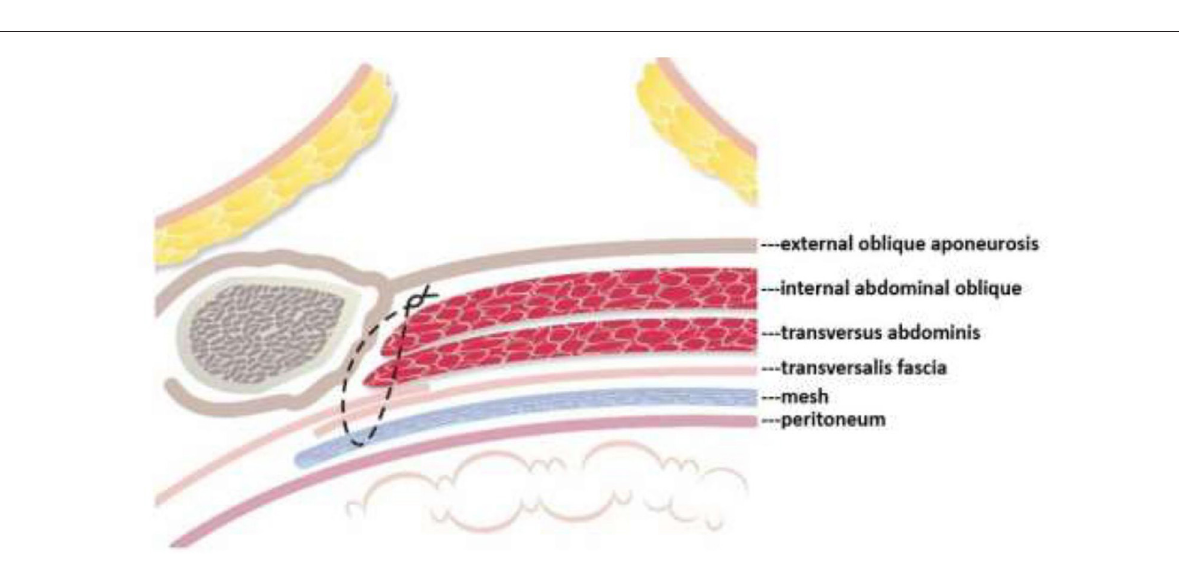
FIGURE 7 | Following TMC repair, aside from the mesh patch itself, the posterior abdominal wall is further protected by a sturdy three layers of autologous tissue—the internal abdominal oblique, transversus abdominis, and the reinforced transversalis